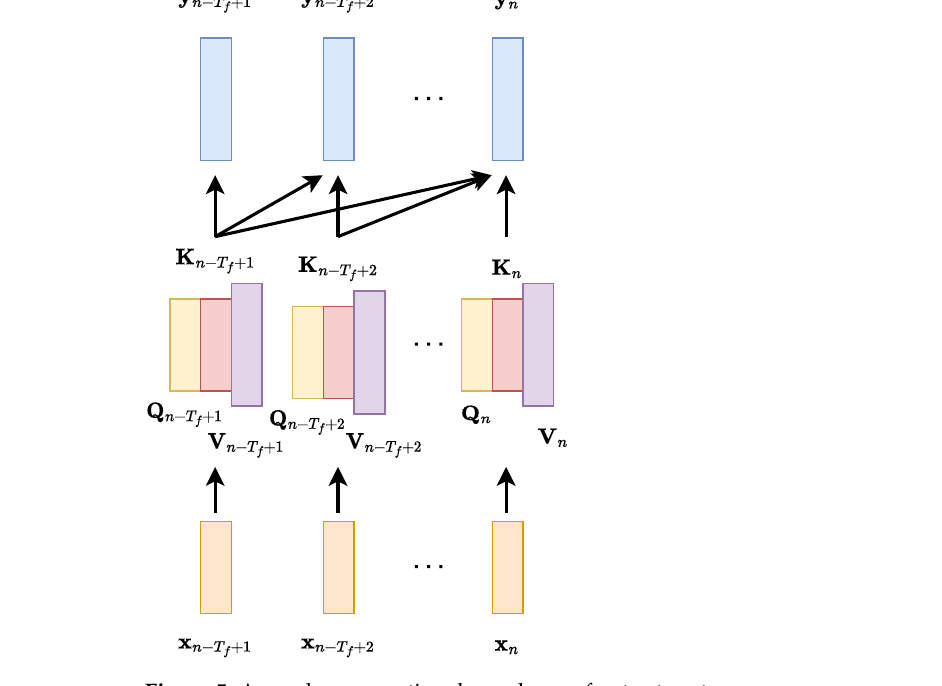
, . . . , y n on vectors computed in f + 1 , . . . , Q n , and values V n − T , . . . , V n . f + 1 f + 1 , . . . , x n f + 1